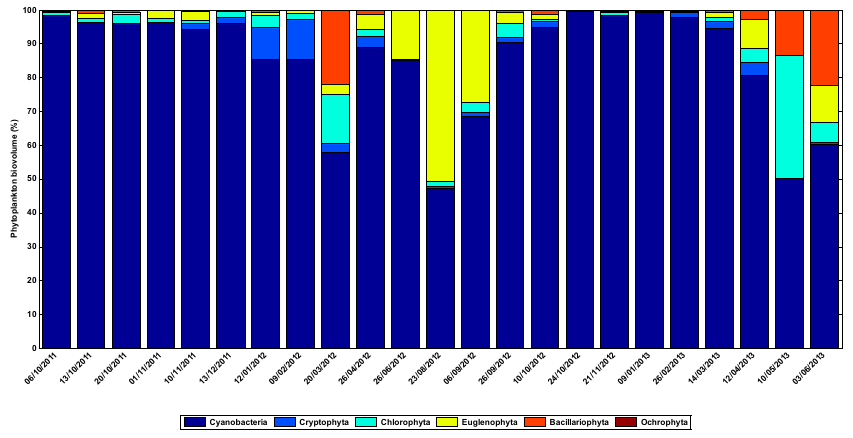
Figure 4. Phytoplankton composition in Lake Pampulha.